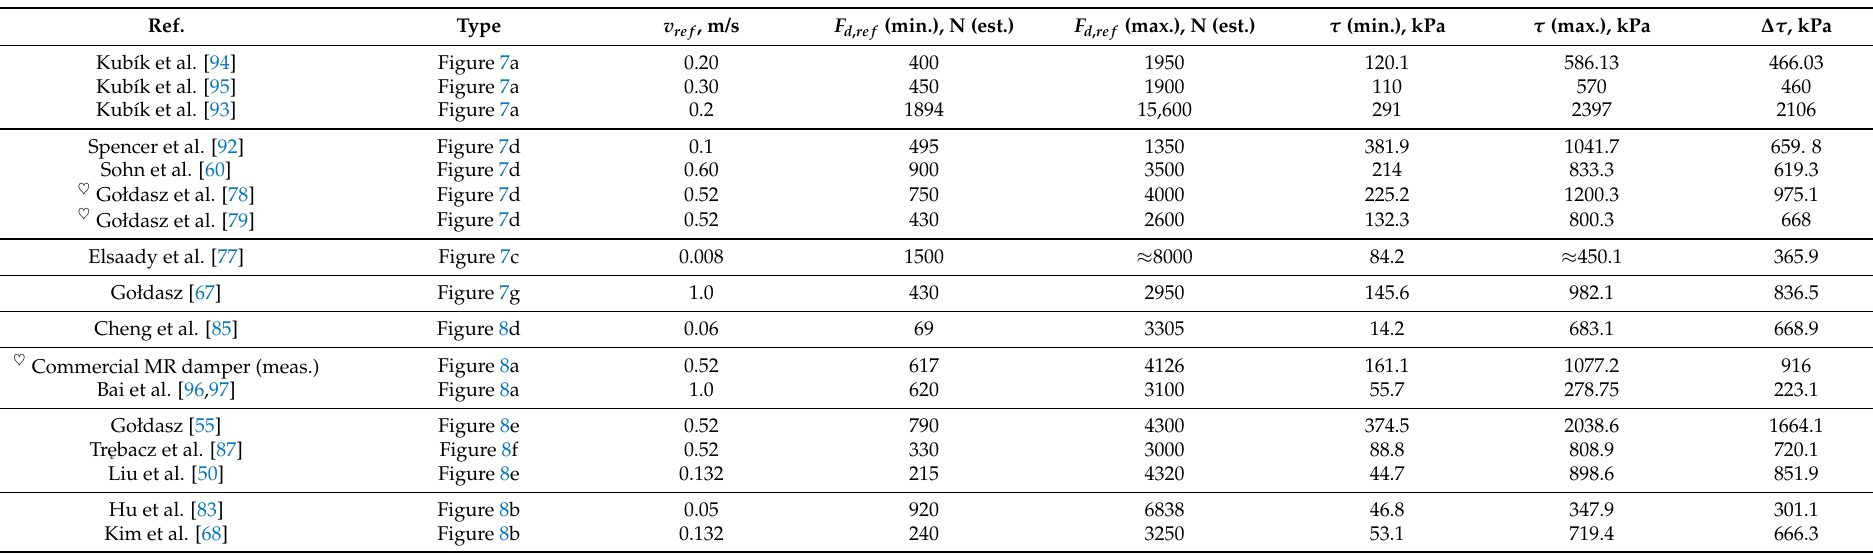
Table 2. Summary: estimated shear stress metrics for selected MR actuator configurations; the ♥ symbols refer to studies using commercial flow-mode MR dampers.